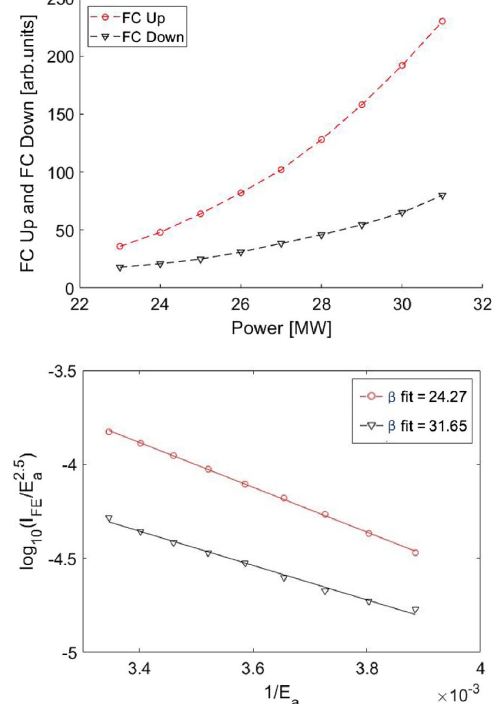
FIG. 16. Dependence of radiation level on power during conditioning (top) and plot in Fowler-Nordheim axes adapted to measured radiation